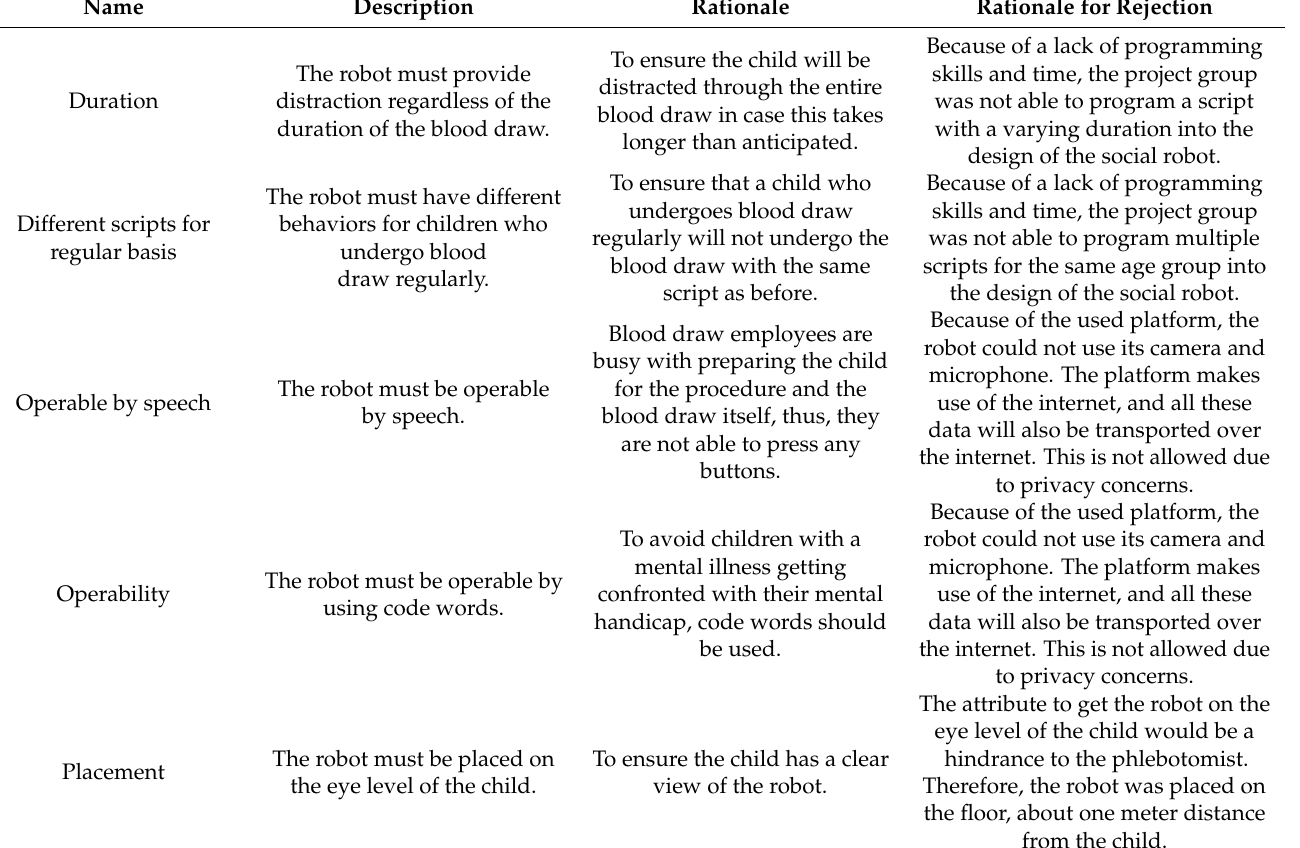
Table 3. Excluded requirements, not implemented in the robot’s